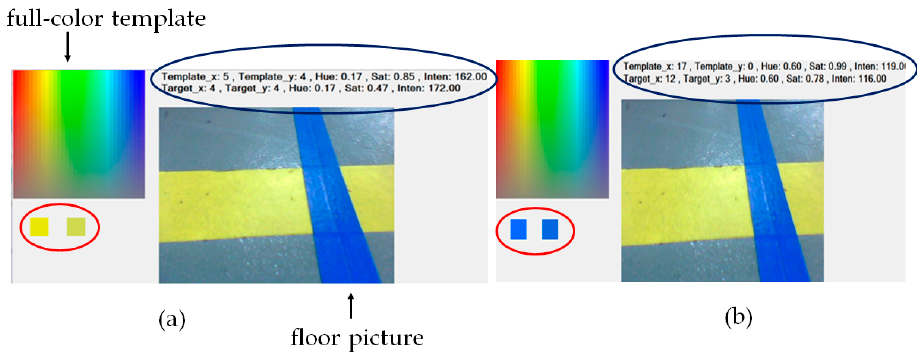
Figure 4. Machine learning analysis. The two yellow blocks in the red circle in Figure 3a are similar in color. The left yellow block in the red circle is from the full-color template, and the right one is from a picture of the yellow line on the floor. The HSI values of the template are: hue (0.17), saturation